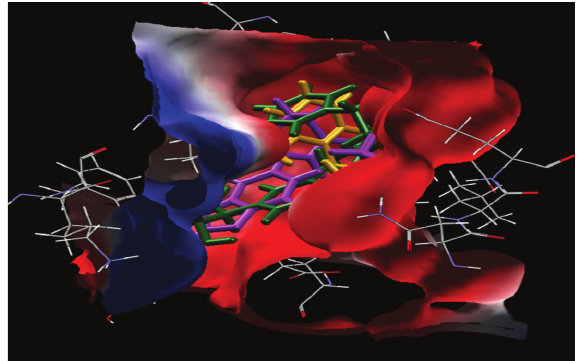
Figure 5: A model showing the binding modes of a compound of training set (compd 3, Table 1), a compound of test set (compd 4, Table 1), and a compound of predicted set (compd 2, Table 2) in purple, yellow, and green, respectively. The red surface shows strong hydrophobic zone and blue one the low hydrophobic